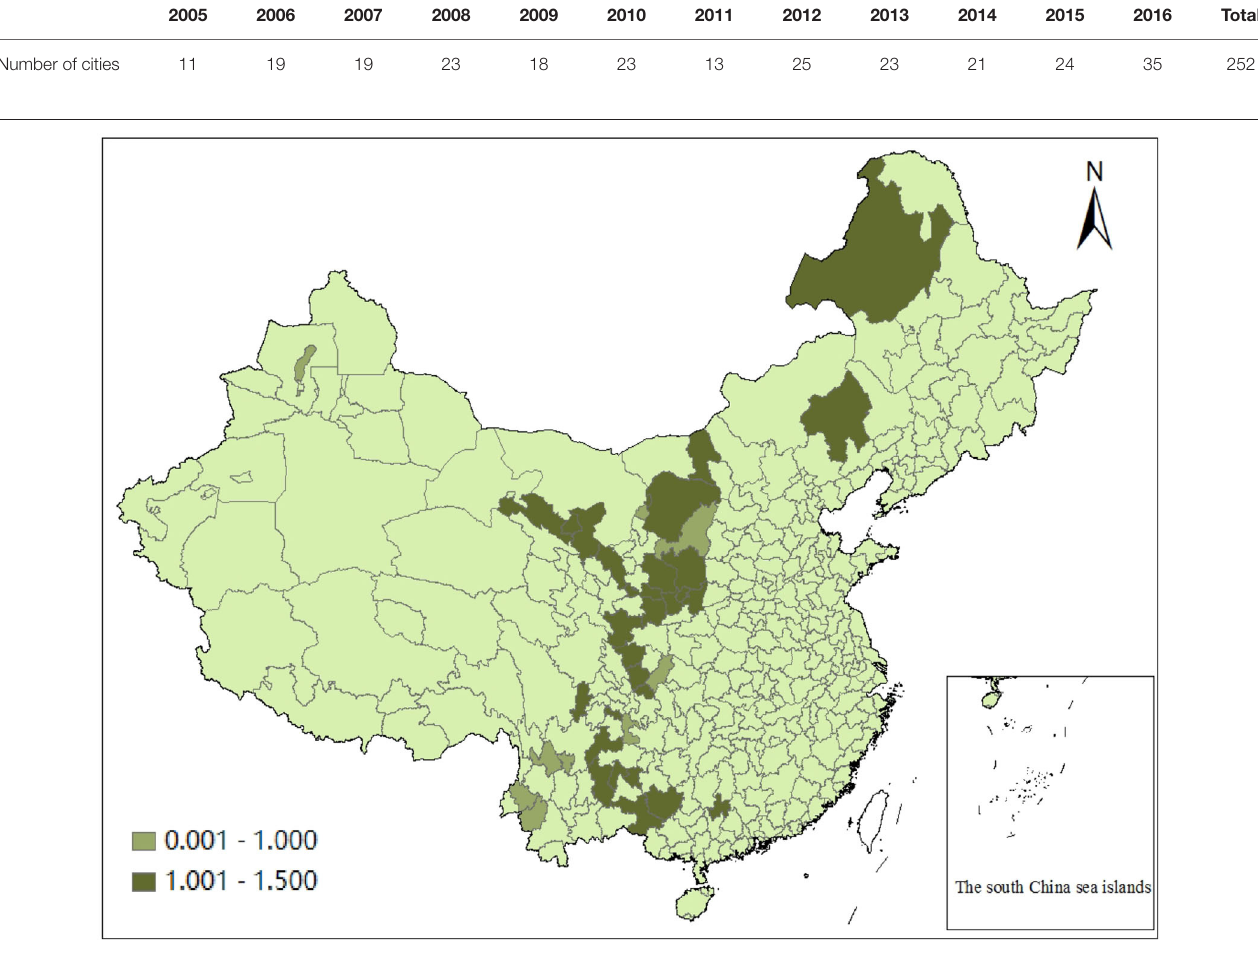
FIGURE 2 | Mean dynamic efficiency of green transformation of resource-based cities in western China from 2005 to 2016.